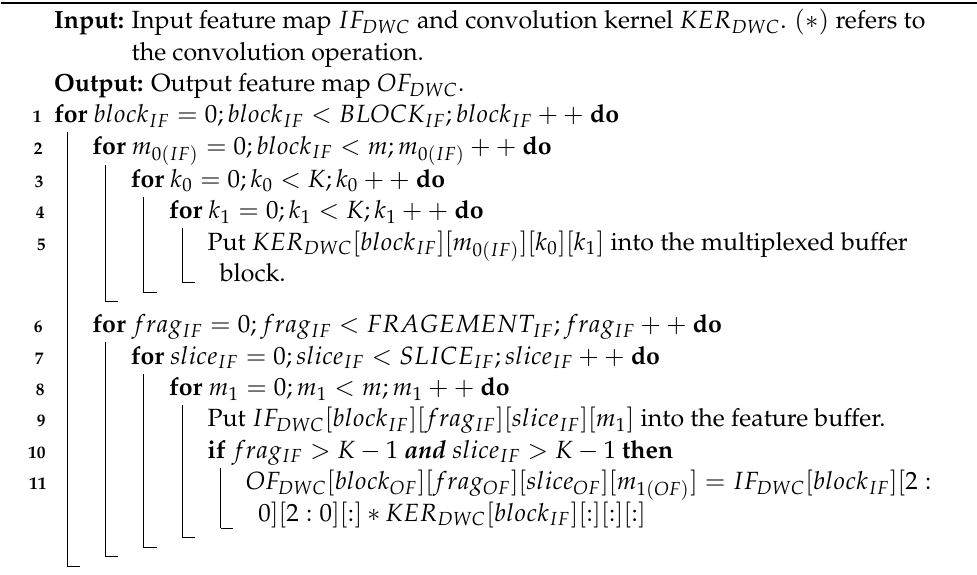
Figure 7. The diagram of convolution order for DWC PUDL and PWC PUPL . By default, m is equal to n . ( a ) DWC calculation using pointwise unit and depthwise loop. K × K × m weights are stored in the on-chip buffer, and are updated after the calculation of a Fragment . Input feature maps need to be read only once. ( b ) PWC calculation using pointwise unit and pointwise loop. The weights are stored in on-chip buffer and updated to another n × IC after the calculation of each Map . Input feature maps need to be read multiple times. ( ∗ ) represents the operation of convolution. Algorithm 1: DWC calculation with PUDL convolution